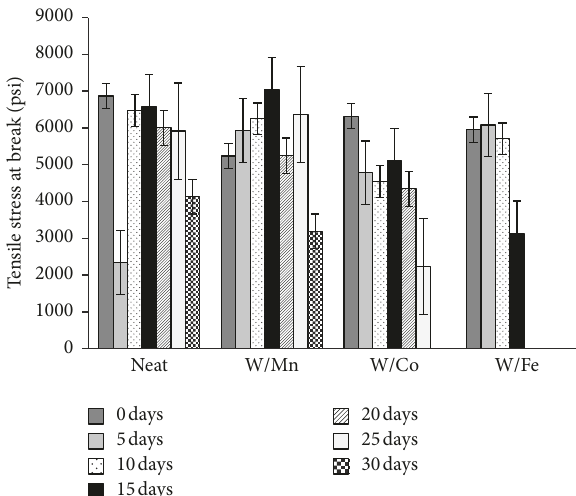
Figure 16: Elongation at break of Apel 8008 COC neat and formulated films with different POA.